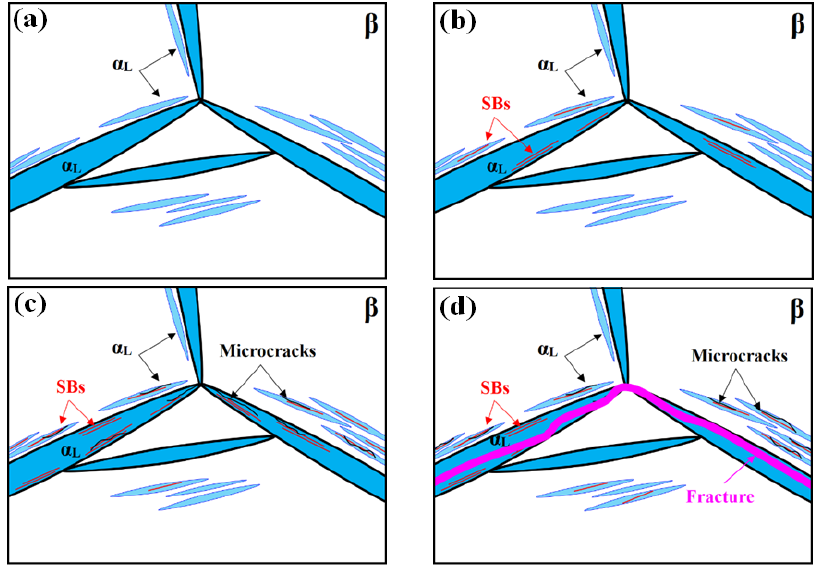
Figure 16. Schematic mechanism showing the evolution of lamellar samples during in situ stretching; ( a ) initial microstructure; ( b ) at a relatively low tensile displacement; ( c ) at a relatively high tensile displacement; ( d ) schematic mechanism of the deformation of lamellar samples after fracture.